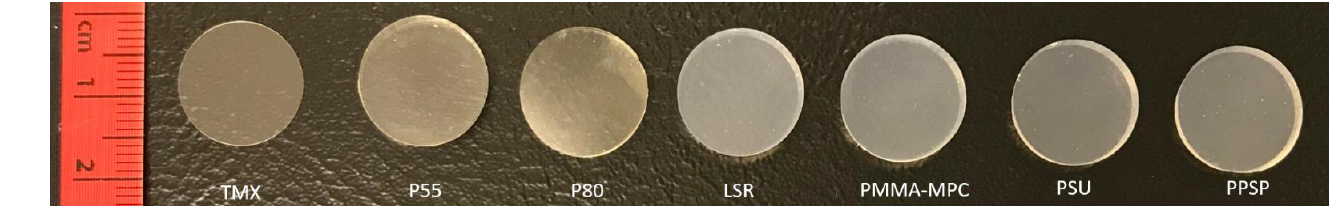
Figure 1. Photographs of all materials used in this study.